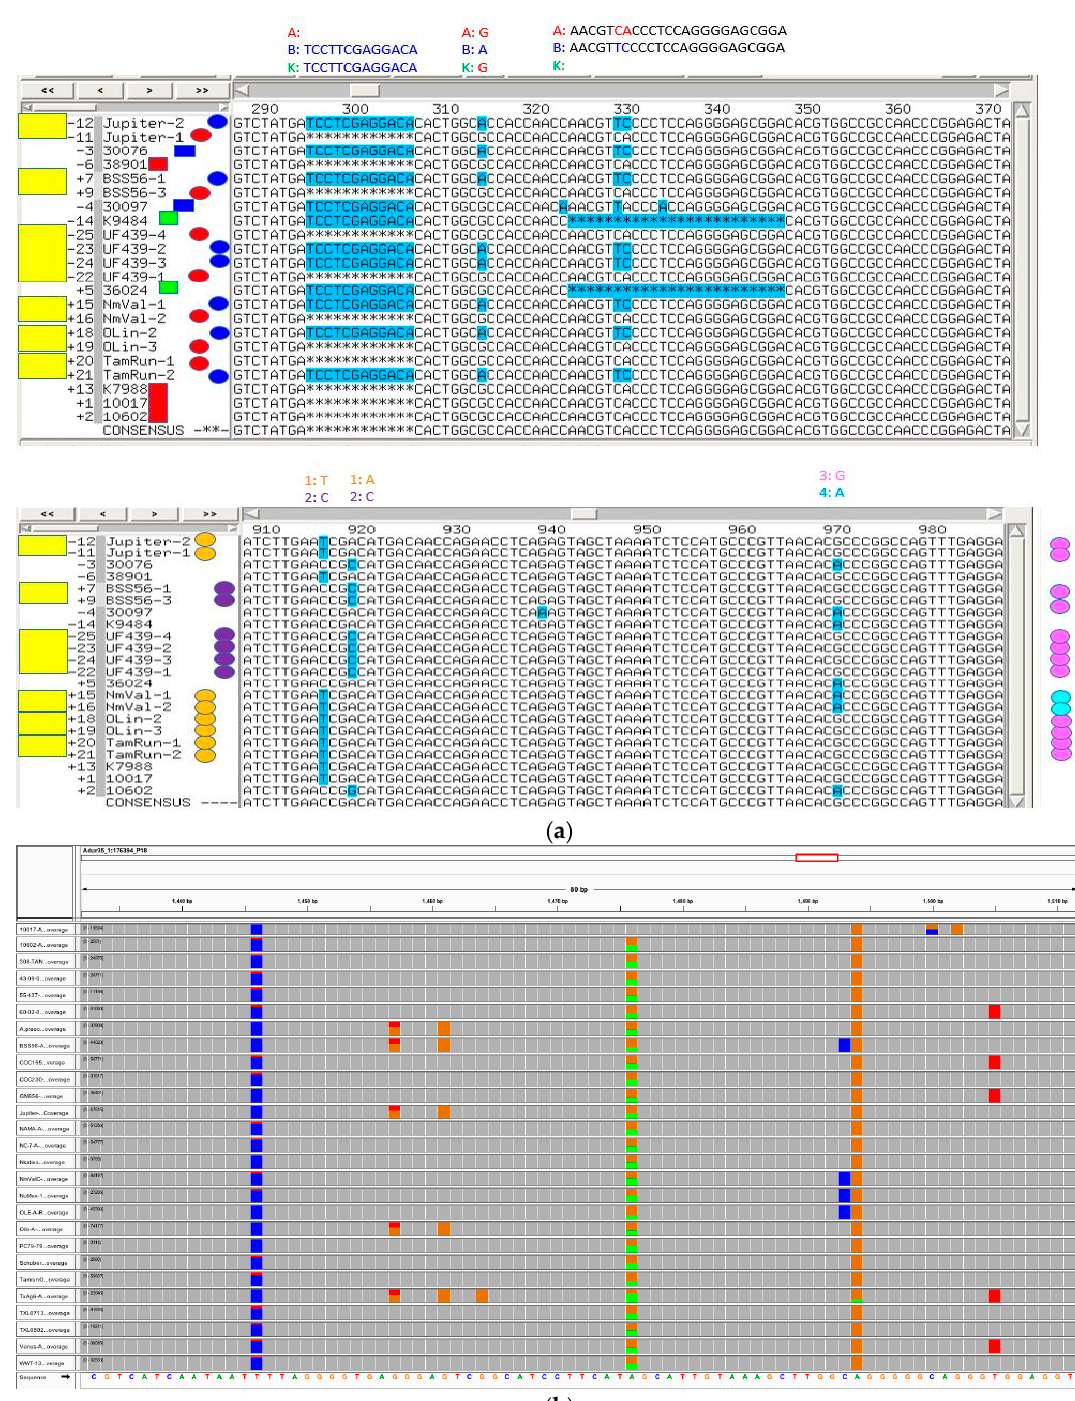
Figure 4. Target sequence with multiple SNPs and indels. ( a )—An example showing homoelogous (top) and homoeologous (bottom) SNPs in tetraploids. Yellow rectangles at left denote tetraploids. Red, blue, and green rectangles (top) denote A, B, and K genome diploids, and red and blue ovals denote A and B genomes in tetraploids. Allele calls are shown above the figure. At bottom are homologous SNPs differentiating tetraploids; SNPs are denoted above the figure as alleles 1 or 2 (orange and purple ovals at left), and 3 or 4 (pink or cyan ovals at right). The order of sequences is the same in the top and bottom figures. ( b ) An example of target sequence in IGV viewer showing multiple SNPs (There are two SNPs showing up in all accessions (blue and orange), which may be referred to as anchor SNPs). The target SNP is highlighted by a red circle.